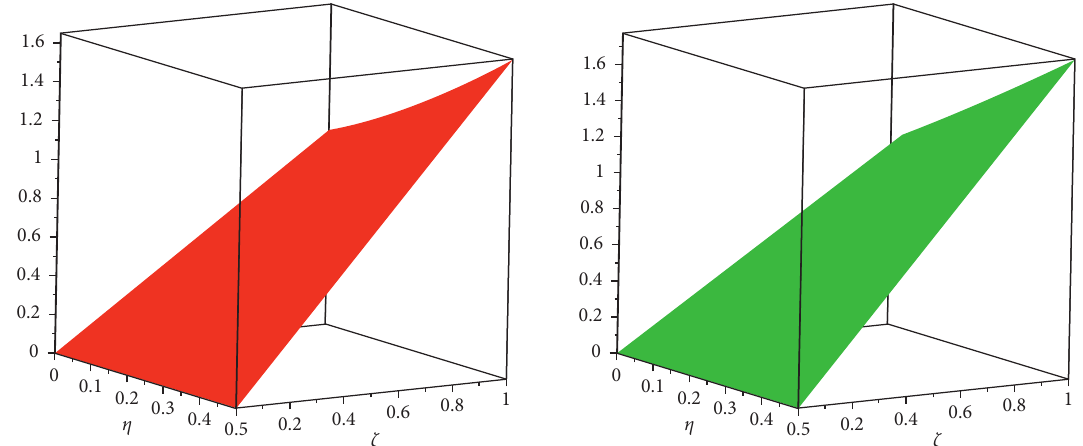
Figure 1: The approximate solution graph of problem 4.1, at δ � 1 and 0.8.